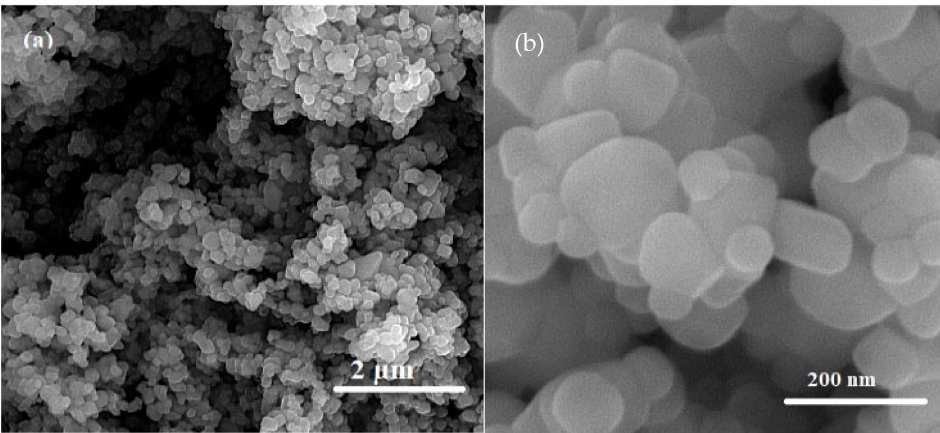
Figure 11. SEM images of TiO 2 NPs at different magnifications ( a , b